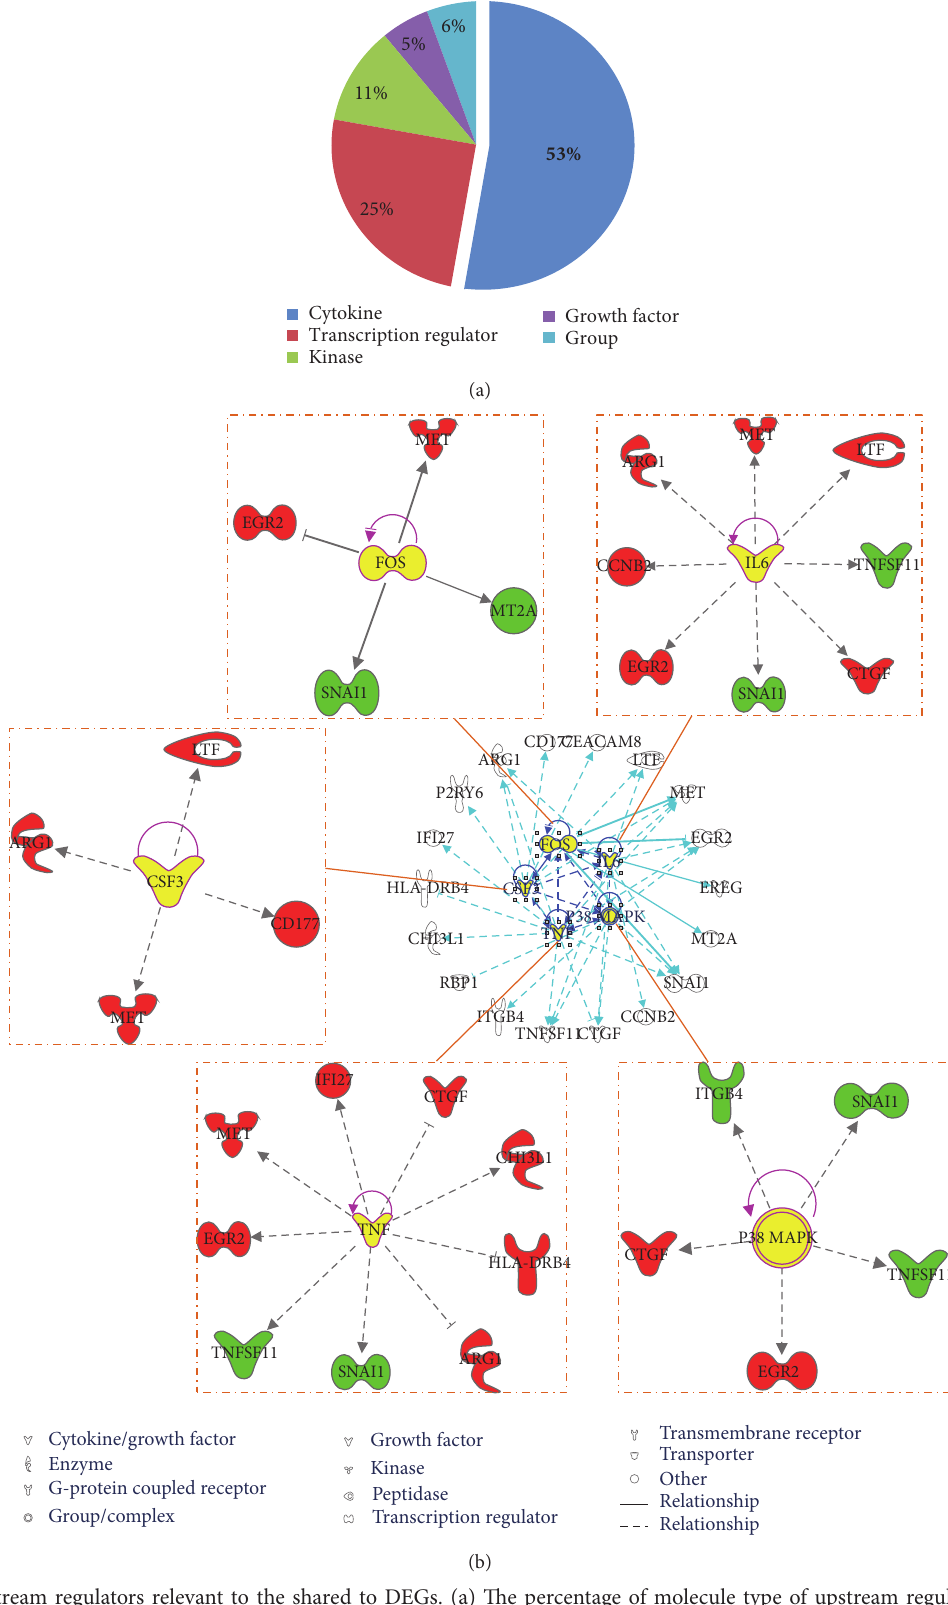
Figure 6: Upstream regulators relevant to the shared to DEGs. (a) The percentage of molecule type of upstream regulator. (b) Top five upstream regulators. Red nodes represent upregulated DEGs; green nodes represent downregulated DEGs. Yellow nodes represent the upstream regulators. Solid lines between molecules indicate a direct physical relationship between molecules, whereas dash lines indicate indirect functional